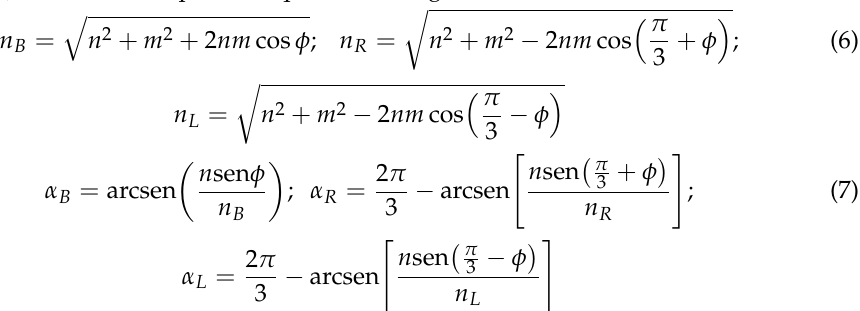
Trilobed bearings consist in the intersection of three eccentric lobes, where the center of each lobe has the same distance from the center of the bearing (ellipticity). This configu- ration allows, in most cases, the formation of three hydrodynamic pressure wedges. The eccentricity ratios for the bottom (b), right (r) and left (l) lobes are given as Equation (6). Equation (7) defines the respective equilibrium angles.